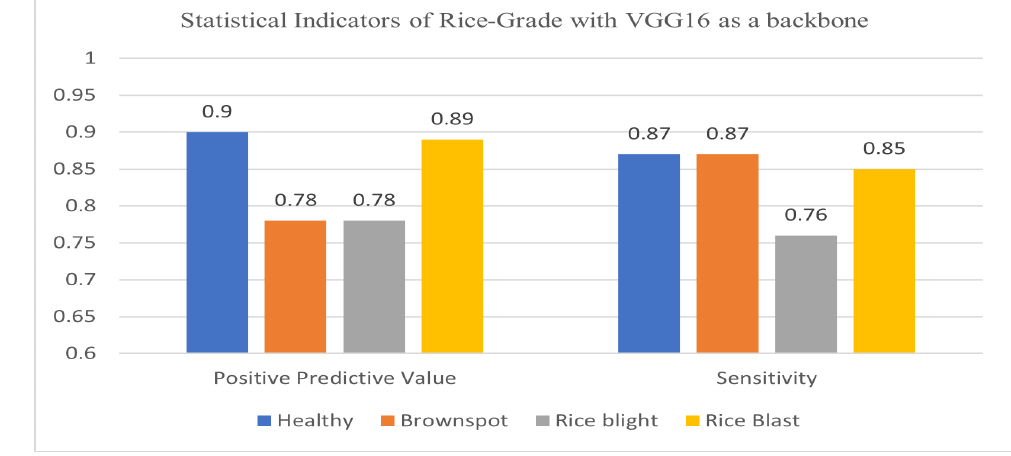
Figure 7. PPV, sensitivity, and DSC of proposed model using VGG16 backbone architecture.